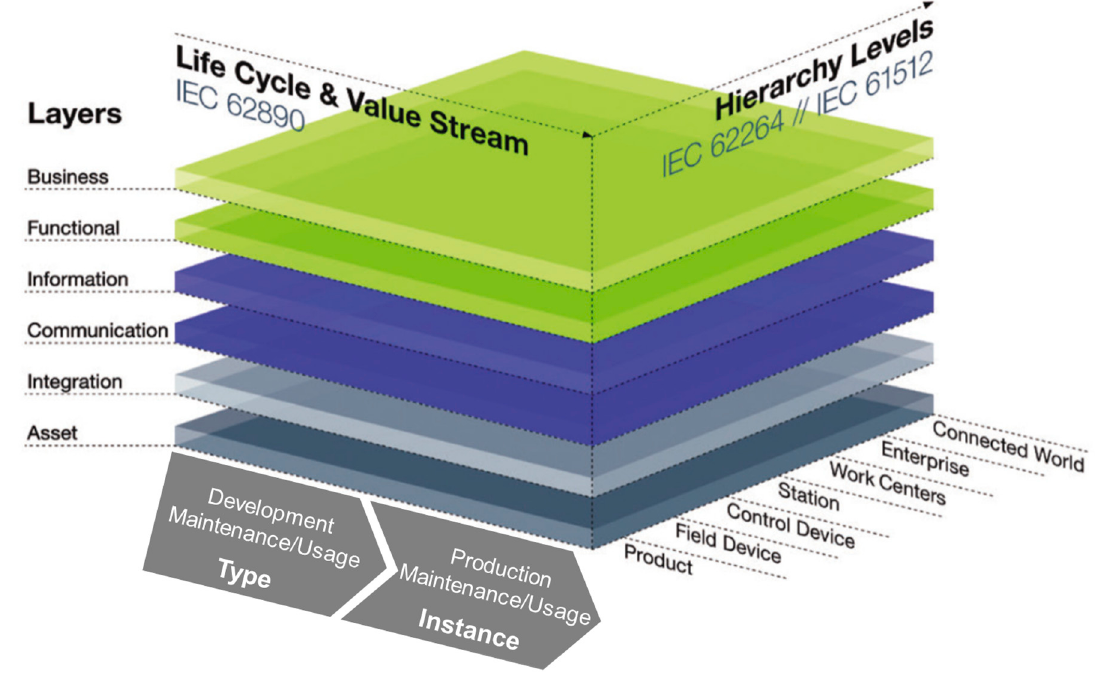
Figure 1. Reference Architectural Model Industry 4.0 (RAMI 4.0) [21].